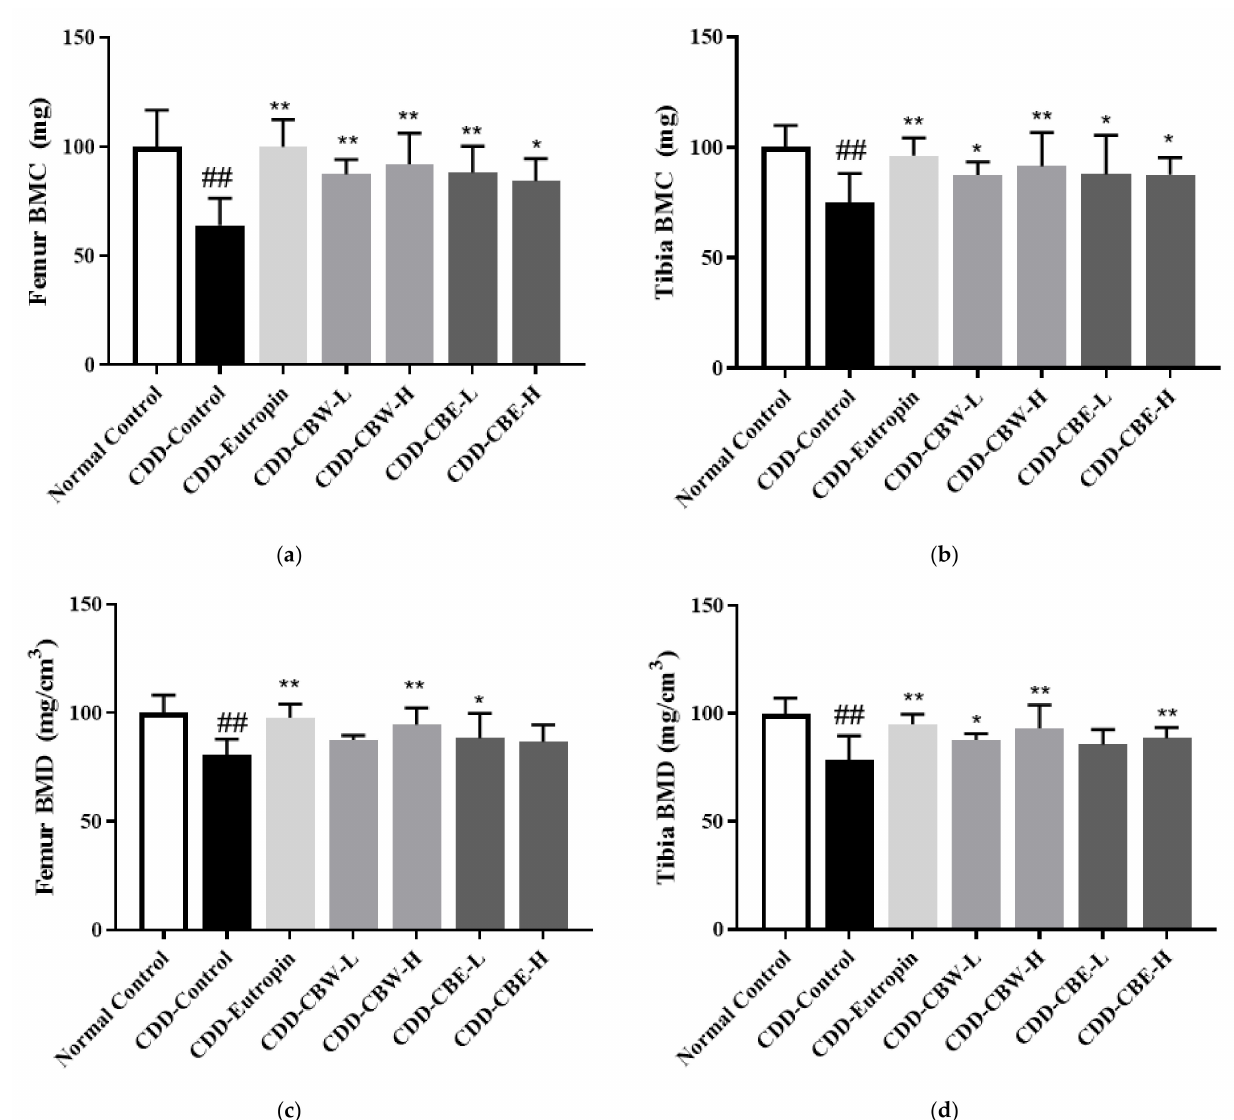
Figure 5. ( a , b ) Femur and tibia bone mineral content (BMC) and ( c , d ) bone mineral areal density (BMD). All data are presented as the mean ± SD ( n = 8 in each group). ## p < 0.001 compared with the normal control group, * p < 0.05, and ** p < 0.01 compared with the CDD-control